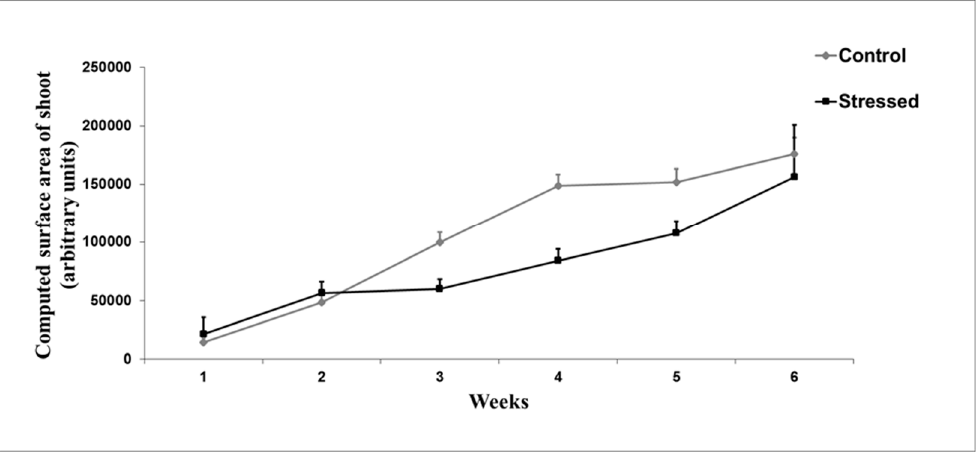
Figure 9. Biomass accumulation (mean ± SE, n = 3) in MMR-deficient DKS10.13 during moderate drought conditions in the greenhouse, as tracked on the phenotyping platform.